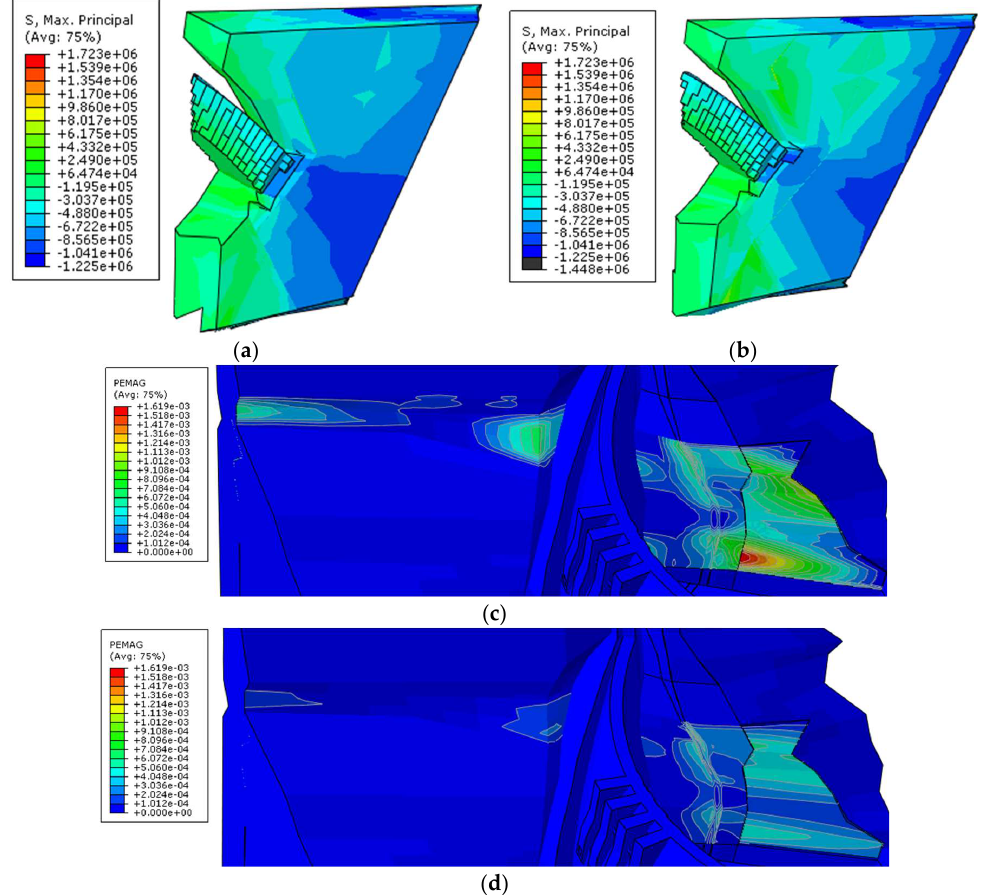
Figure 17. The first principal stress and yielding region distribution of the left abutment (Stress unit: Pa. PEMAG: plastic strain magnitude) . ( a ) before concrete replacement; ( b ) after concrete replacement; ( c ) before concrete replacement; ( d ) after concrete replacement.